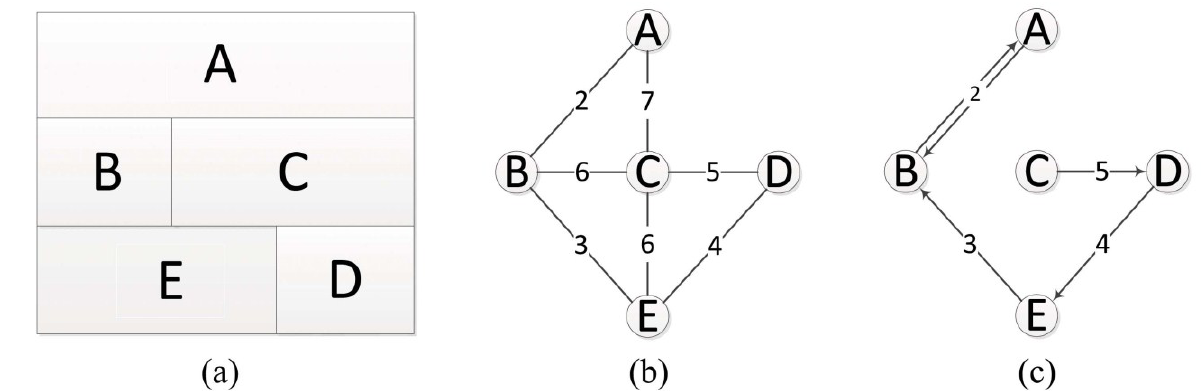
Figure 3. An Example of region adjacent graph (RAG) and nearest neighbor graph (NNG). ( a ) The location of objects; ( b ) The RAG and ( c ) The